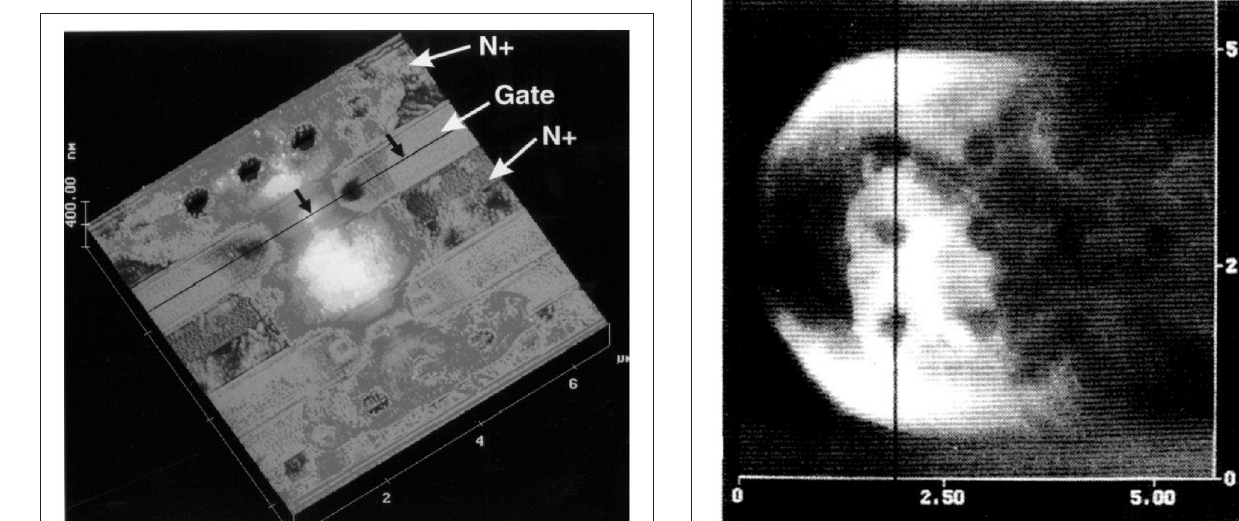
Frontiers in Materials |